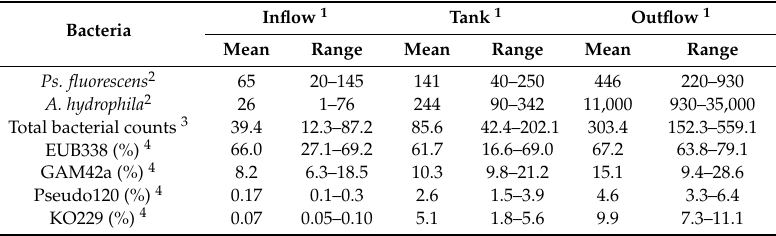
Table 2. The counts of Ps. fluorescens and A. hydrophila determined by a culture-dependent method, total DAPI cell counts and the relative percentage of cells hybridized with specific probes in the water of RAS during farming of European grayling ( Thymallus thymallus L.) broodstock.